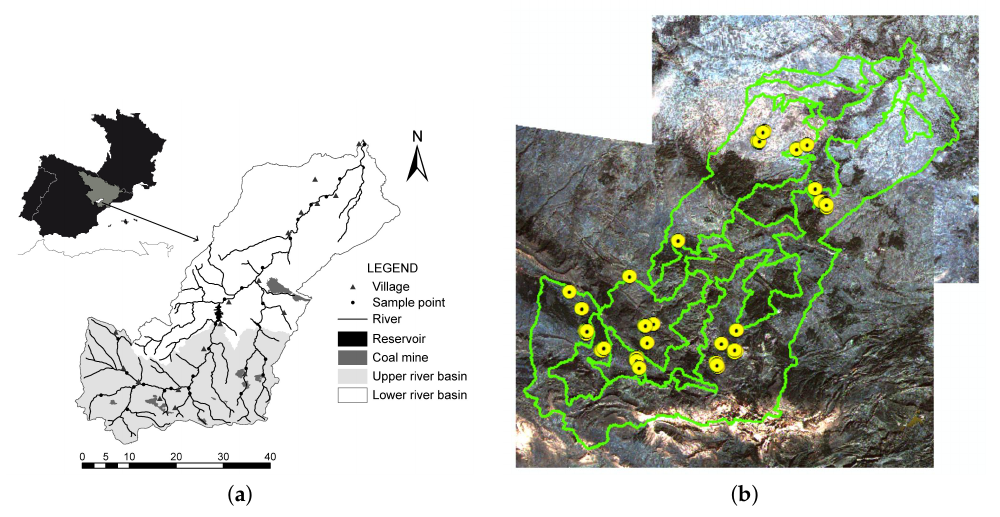
Figure 2. ( a ) Map showing the Rio Martin watershed in Zaragoza, Spain (permission from Matta Trabucchi). ( b ) Field sites’ location in Rio Martin